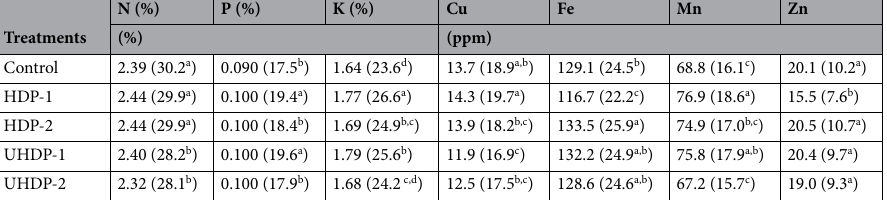
Table 3. Effect of planting density on leaf nutrient contents (pooled data for 2015–16 to 2019–20). Figures under parenthesis are transformed values. Means with at least one letter common are not statistically significant using TUKEY’s Honest Significant Difference at 5% Control: Planting at 6 m (row to row) × 6 m (plant to plant) spacing (tree density—277 plants ha −1 ), HDP-1: Planting at 6 m (row to row) × 3 m (plant to plant) spacing (tree density—555 plants ha −1 ), HDP-2: Planting at 4 m (row to row) × 4 m (plant to plant) spacing (tree density—625 plants ha −1 ), UHDP-1: Planting at 4 m (row to row) × 2 m (plant to plant) spacing (tree density—1250 plants ha −1 ), UHDP-2: Planting at 2 m (row to row) × 2 m (plant to plant) spacing (tree density—2500 plants ha −1